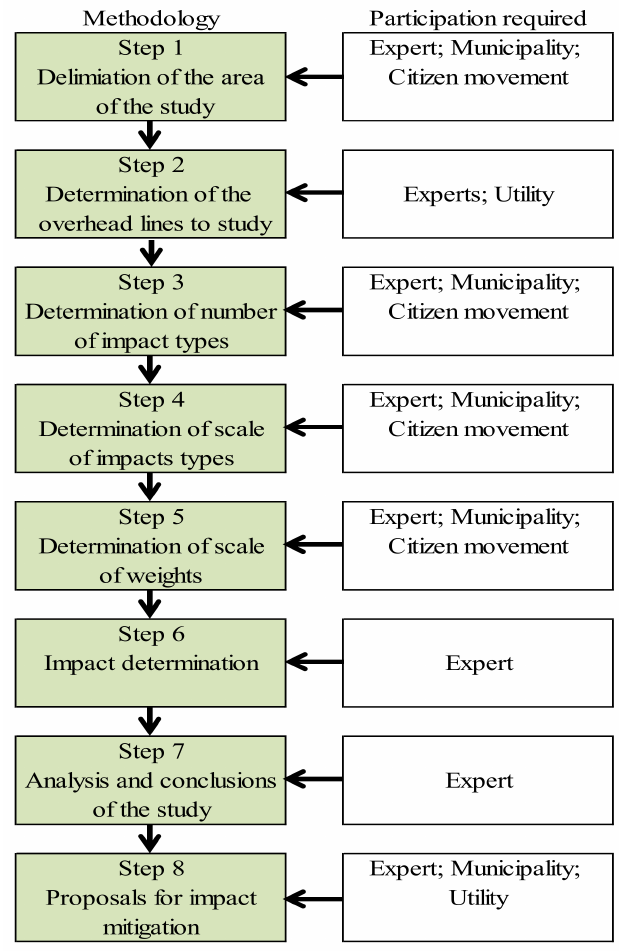
Figure 1. Methodology to evaluate the overall impact of overhead lines in urban